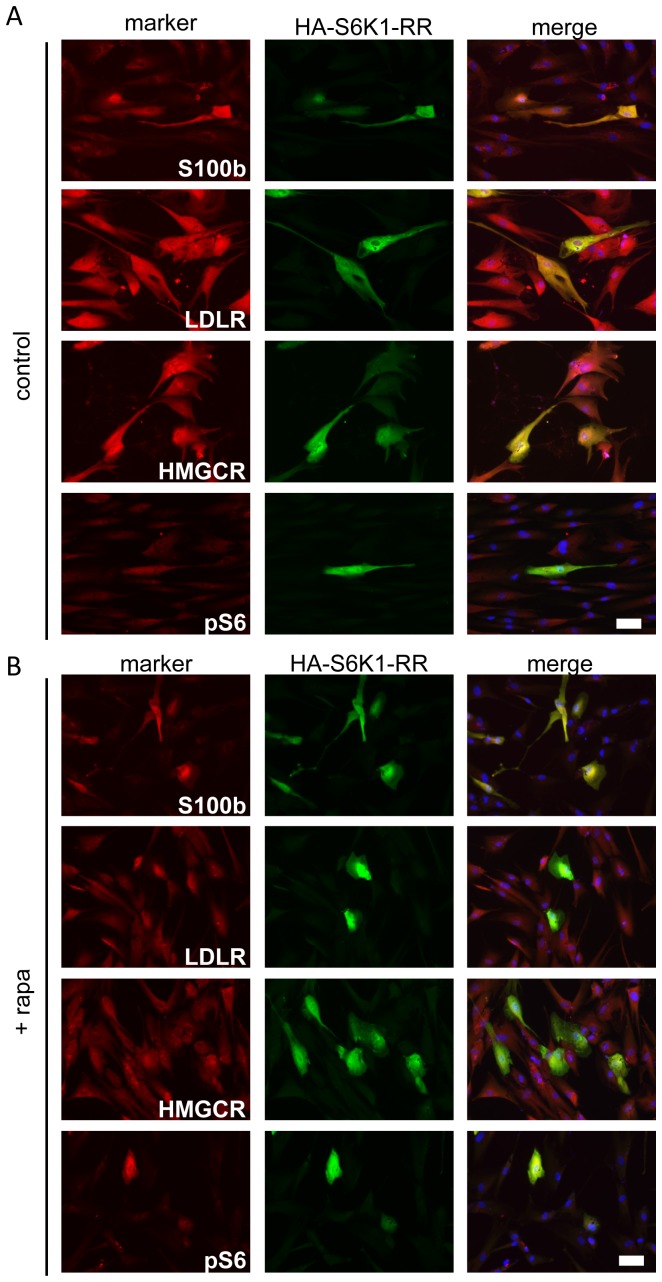
Rapamycin resistant S6K1 induces S100b, but not LDLR or HMGCR expression.(A) AFS cells were differentiated without or (B) in the presence of rapamycin and at day 15 cells were transfected with an HA-fused S6K1 rapamycin-resistant mutant (HA-S6K1-RR). After 72 hours in differentiation media containing rapamycin, cells were fixed and stained with anti-HA antibody (shown in green) combined with antibodies detecting S100b, LDLR, HMGCR and phosphorylated S6 (shown in red). Scale bar represents 25 µm.